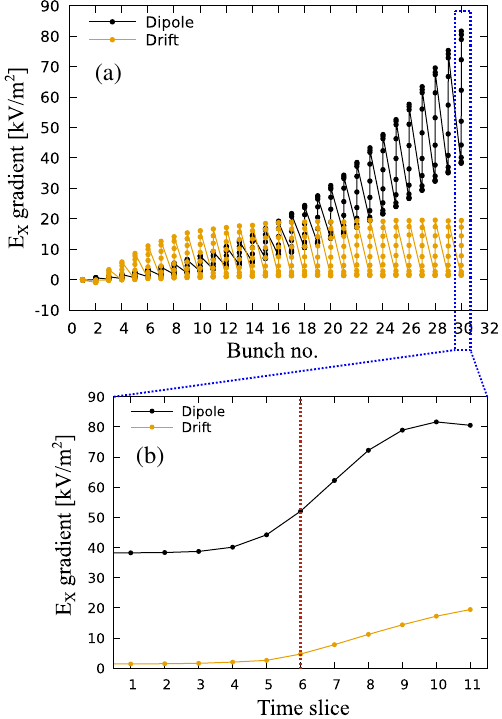
FIG. 24. (a) Horizontal electron cloud space-charge electric field gradients for the 11 time slices within each of 30 bunches for dipoles and field-free regions. (b) Electric field gradients for the 11 time slices in bunch 30, showing the center of the bunch at time slice 6. (Beam energy is 2.1